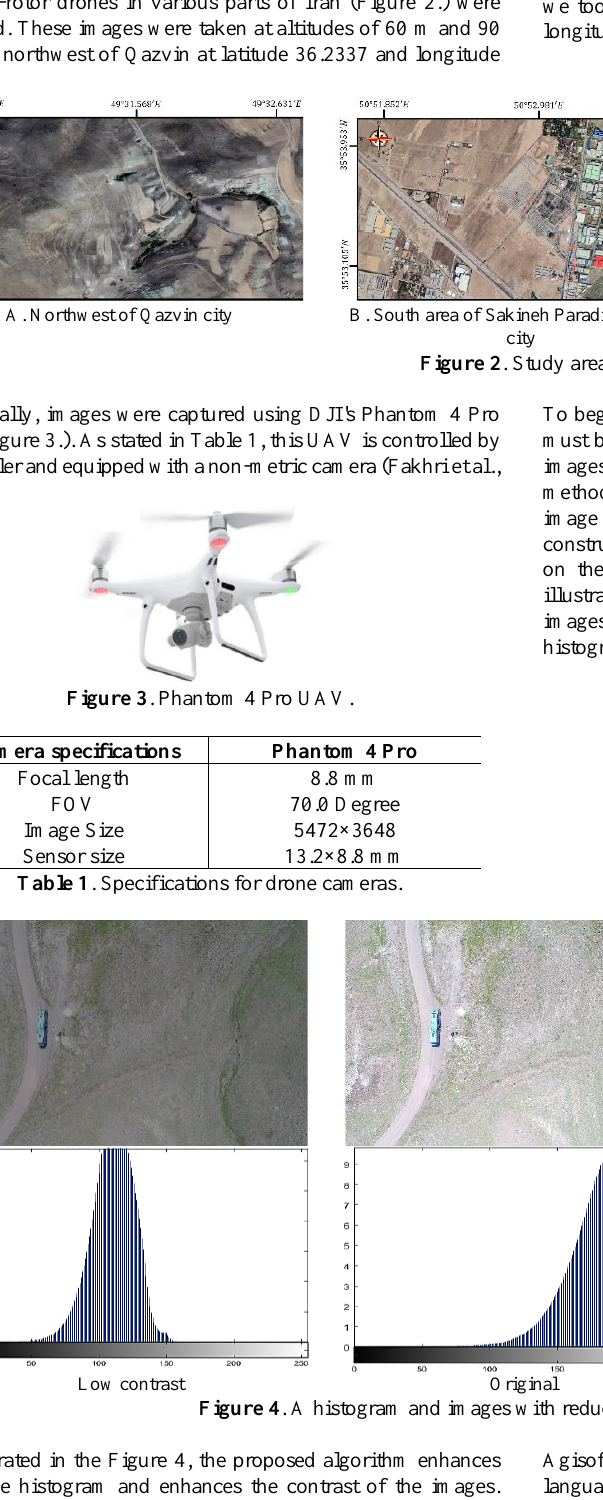
Figure 4 . A histogram and images with reduced contrast and